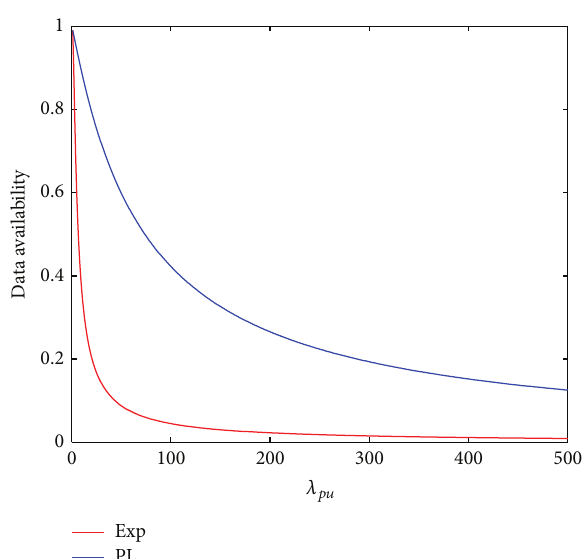
Figure 5: The impact of the data publishing rate on